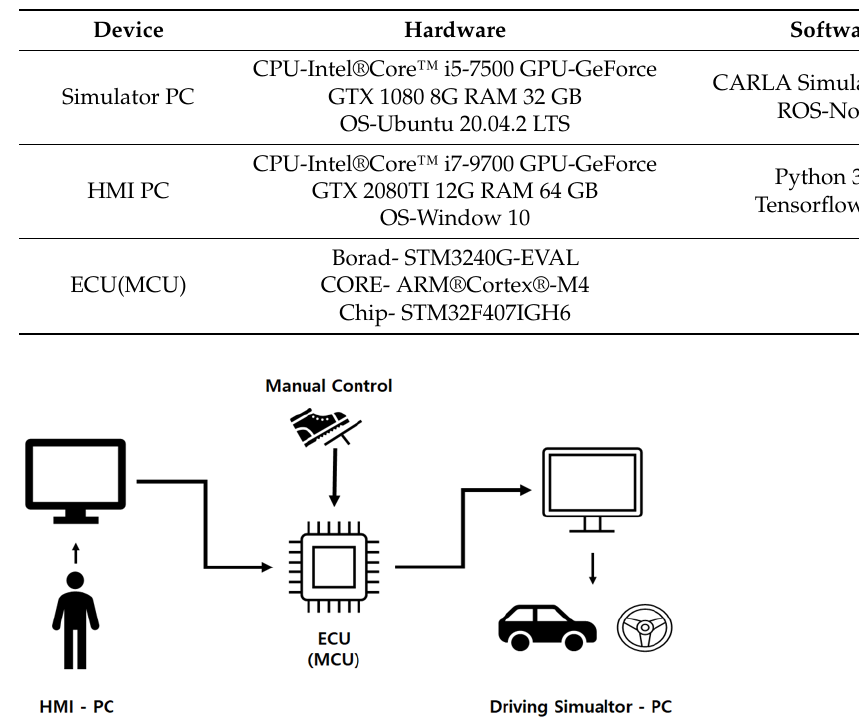
Table 2. Experimental environment.